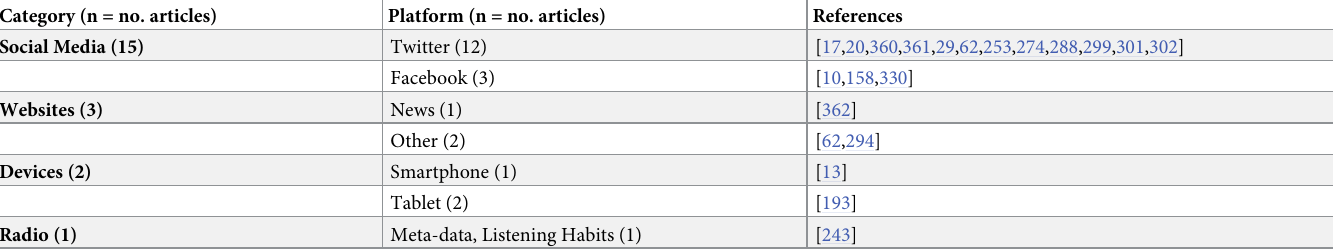
Table 13. Number of articles predicting ethnicity or race, with associated platforms and references. Category (n = no. articles)